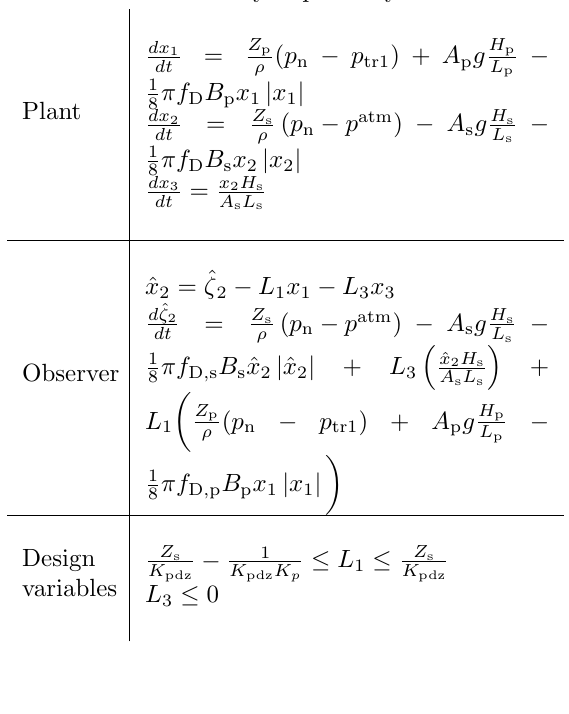
Table 1: Summary of the reduced order nonlinear ob- server for the hydropower system.